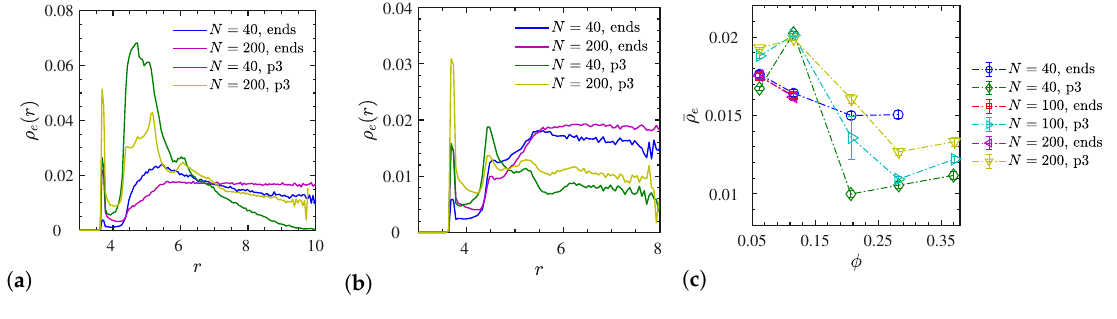
Figure 12. Mean number of ( a ) polymer–polymer entanglements per chain Z and ( b ) polymer–NP entanglements per chain Z NP , both calculated in the frozen NP limit. ( c ) Polymer–polymer entanglements per chain Z 0 in the phantom-limit (NPs ignored in the analysis). Data shown only for dispersed systems as a function of NP volume fraction. Dash-dotted lines are guides to the eye.